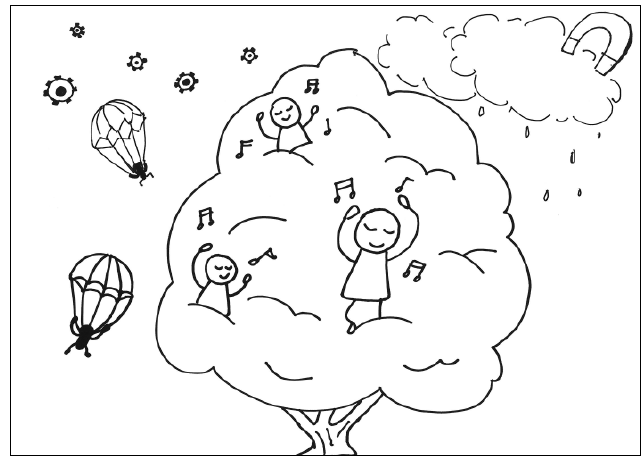
Figure 8. Work by D2 Mild Depression.